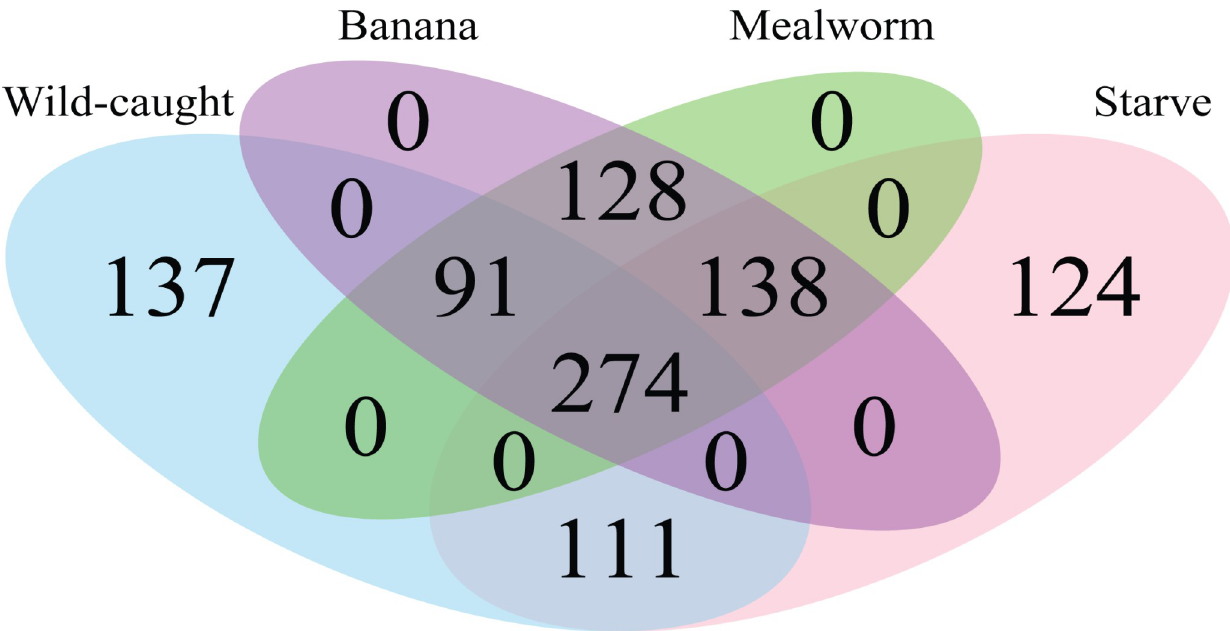
Fig 3. Venn diagram of phylotypes present in aggregate communities by diet